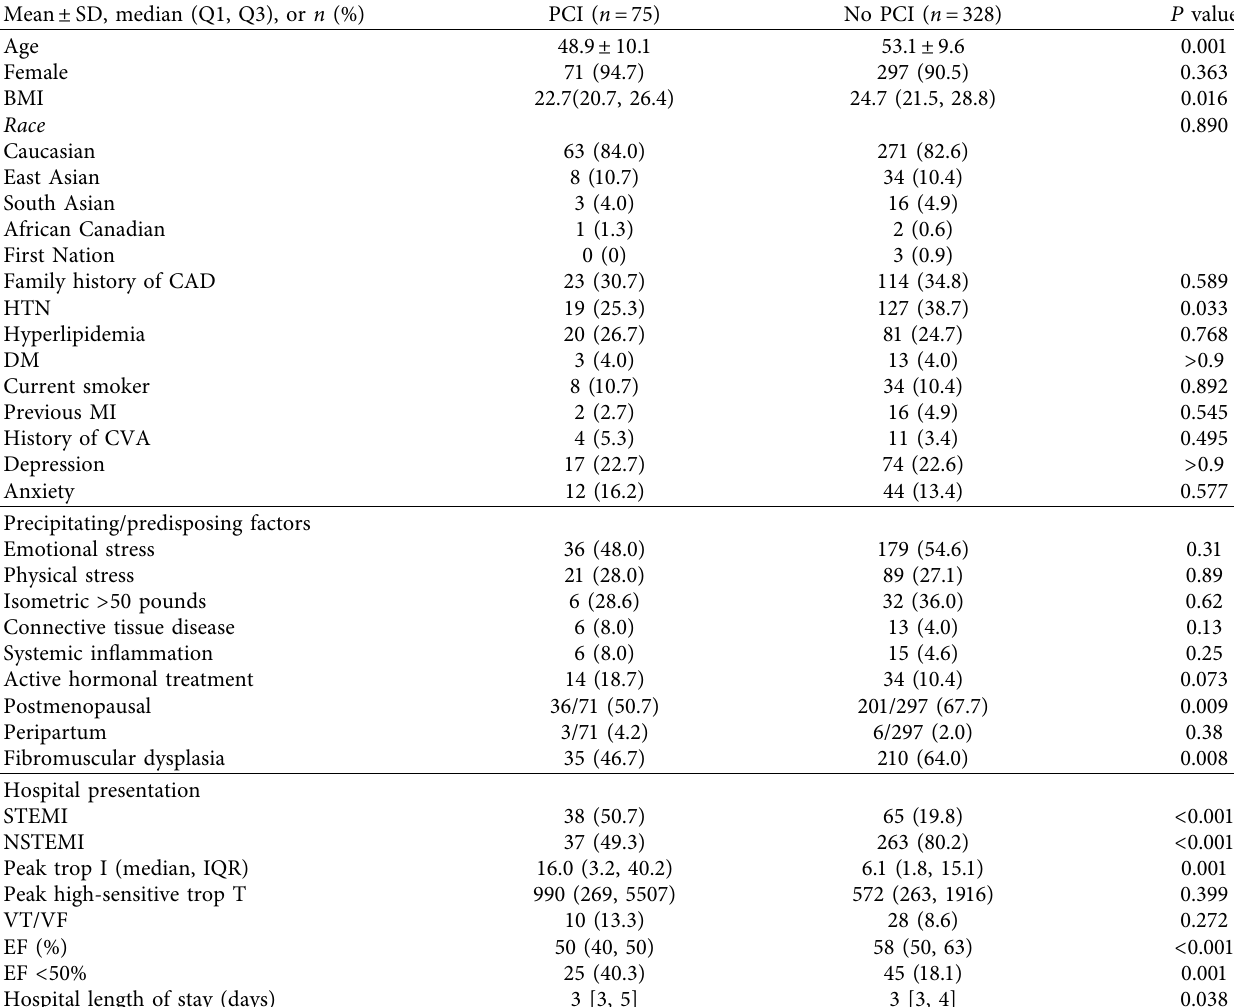
Table 1: Baseline and hospital